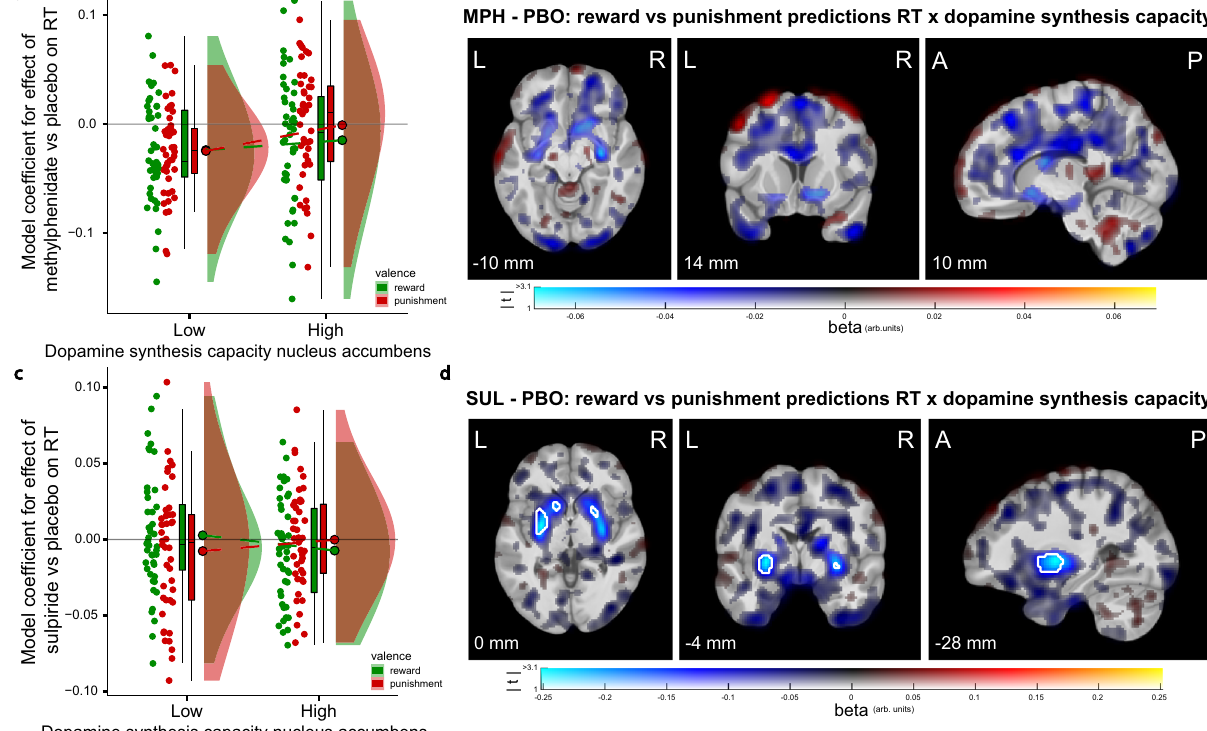
participants ’ modelcoef fi cients for the methylphenidate× valence interaction effect on response times as covariates. c , d Same as a , b , but for the effect of sulpiride. Boxplots and round dots next to distribution kernels are de fi ned as in Fig. 1c. Figure conventionsofthevoxel-wiseimagesareasinFig.1b. N =88participants.Sourcedata are provided with this paper. MPH methylphenidate, SUL sulpiride, PBO placebo, RT response time, arb. units arbitrary units, k i cer dopamine synthesis capacity